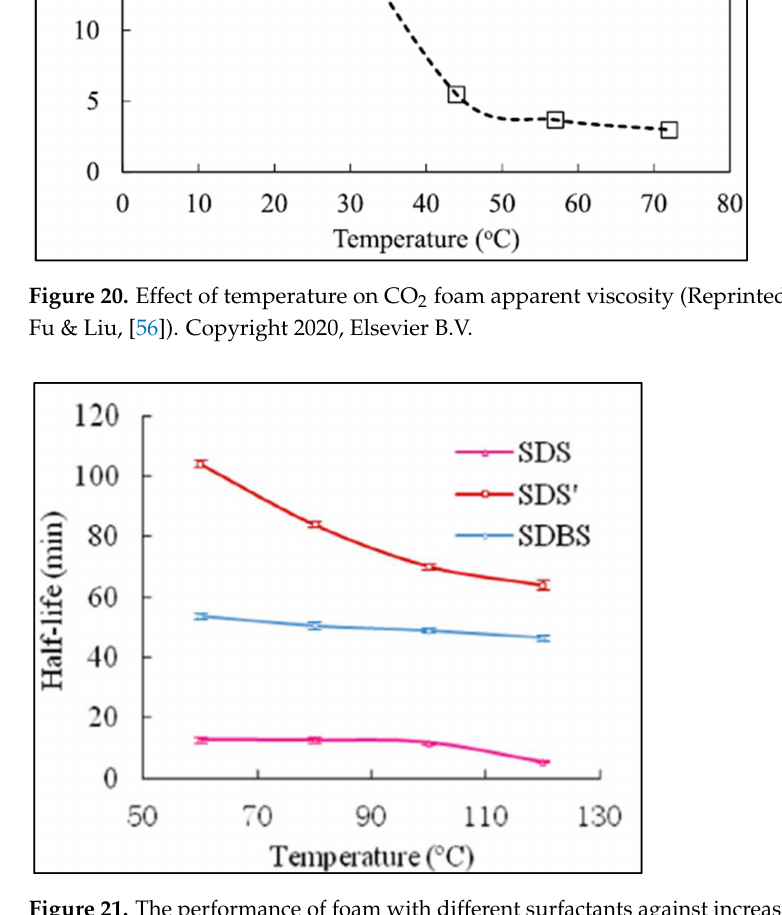
Figure 21. The performance of foam with different surfactants against increasing pressure (Reprinted with permission from Wang et al. [61]). Copyright 2017, Elsevier